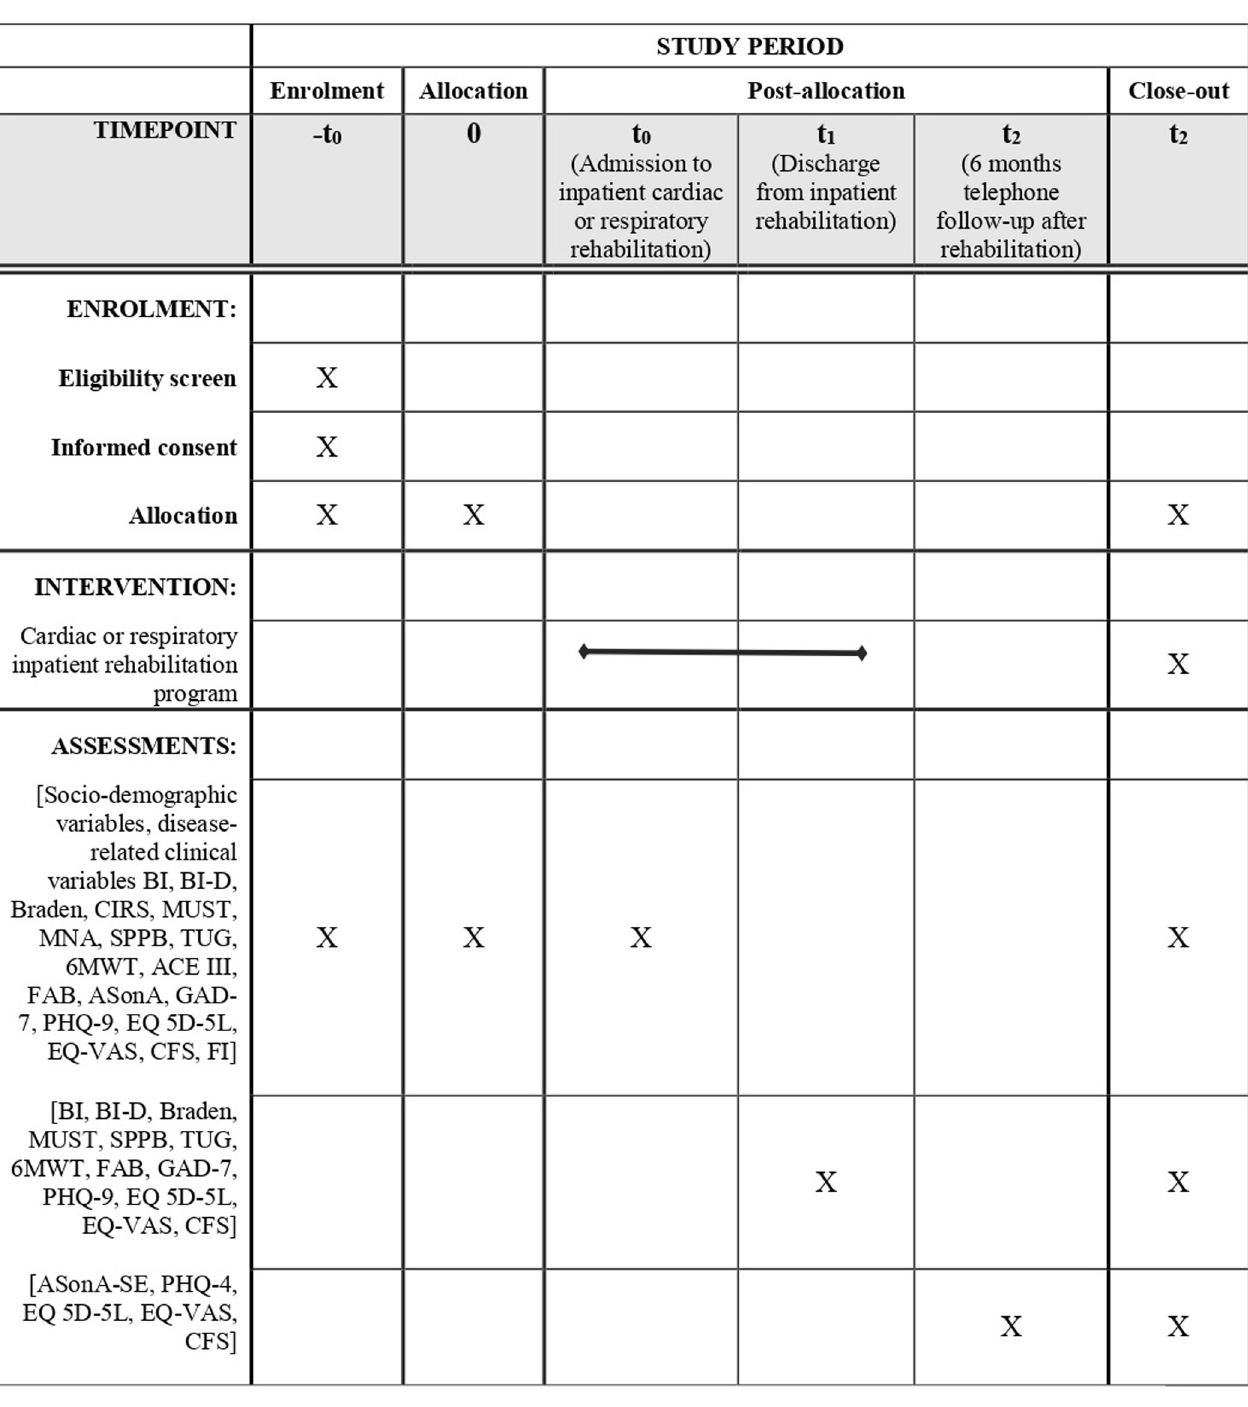
PLOS ONE | https://doi.org/10.1371/journal.pone.0272132 August 4, 2022 7 /